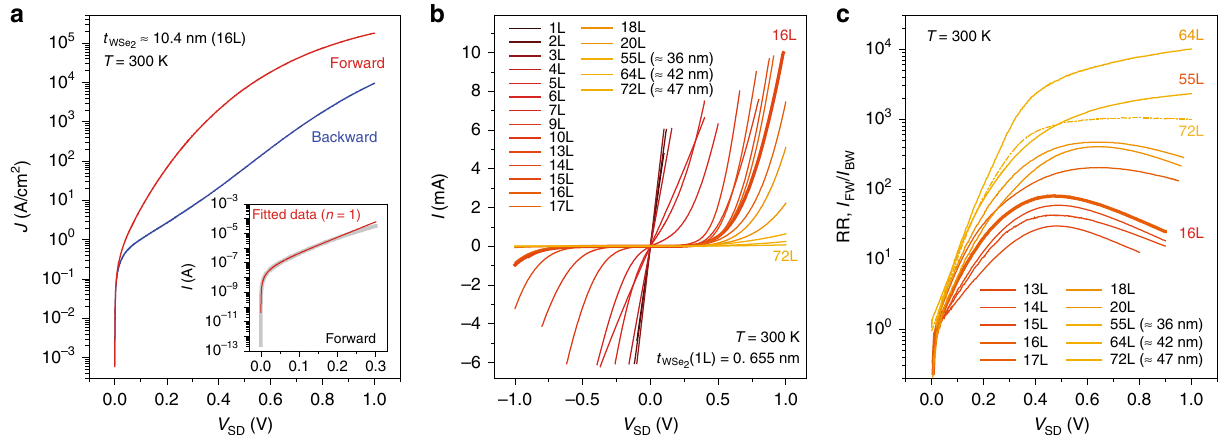
≈ 10.4 nm), revealing a high current WSe 2